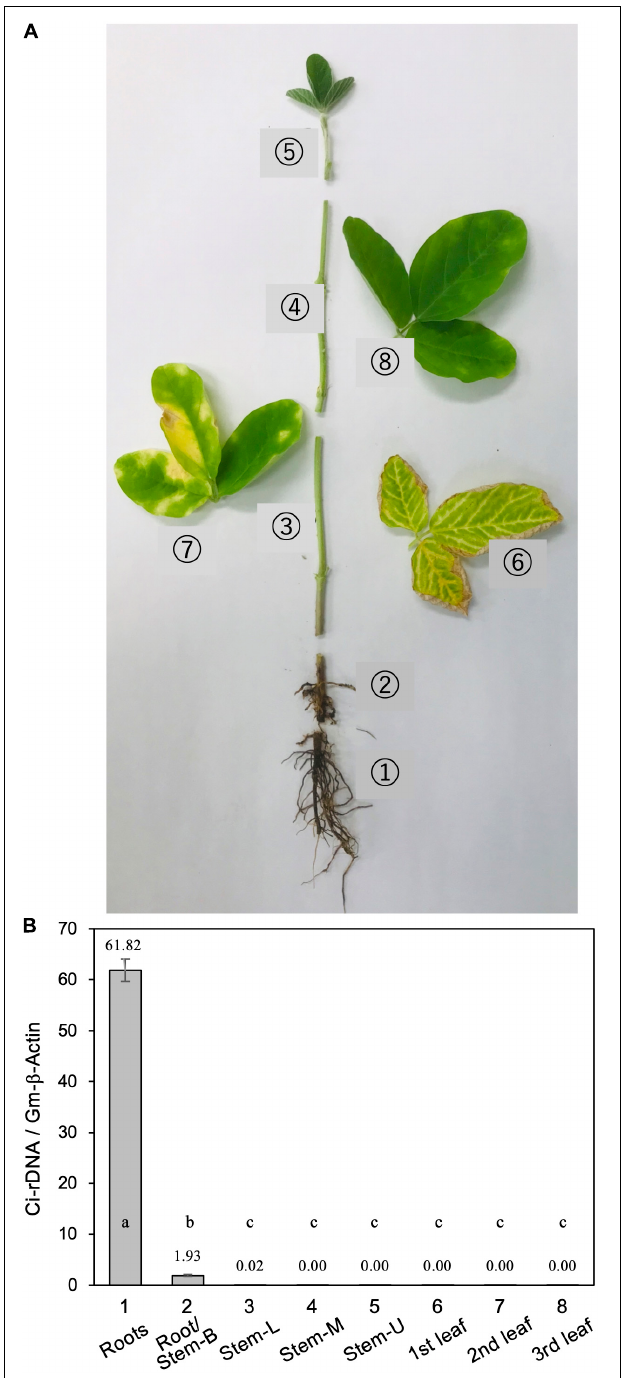
FIGURE 1 | (A) Typical disease symptoms of red crown rot in a diseased soybean plant. The photograph was taken 5 weeks after inoculation with Calonectria ilicicola (isolate UH2-1). Eight different parts (1–8) of from three diseased plants were sampled for measurement of relative fungal growth: (1) roots, (2) roots and stem base (Roots/stem-B), (3–5) lower (Stem-L), middle (Stem-M), and upper (Stem-U) portions of stem, and (6–8) first, second, and third trifoliate leaves. (B) Relative fungal growth in different parts of diseased soybean plants. Values are means ± SD, n = 3 plants. Different letters indicate significant differences (Turkey’s multiple comparison test, p <